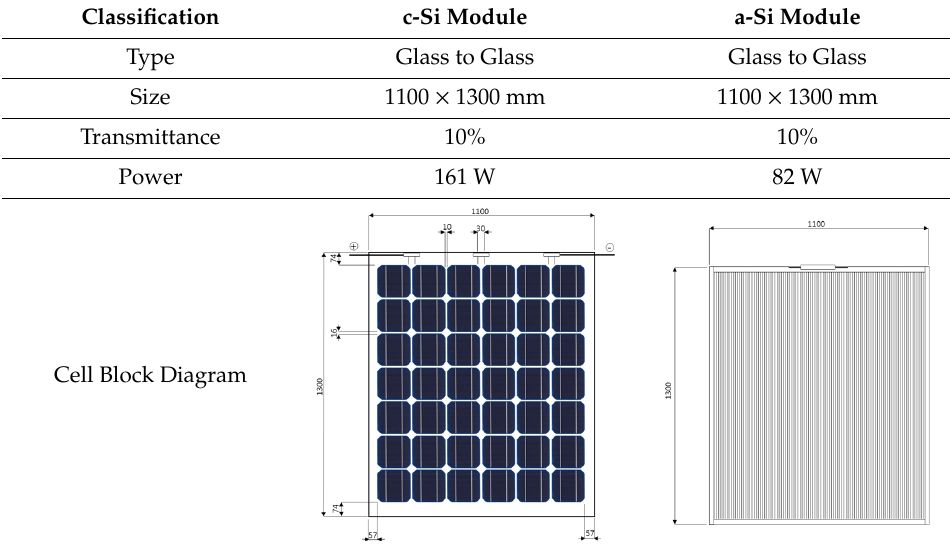
Table 1. Characteristics of the photovoltaic (PV) modules used.